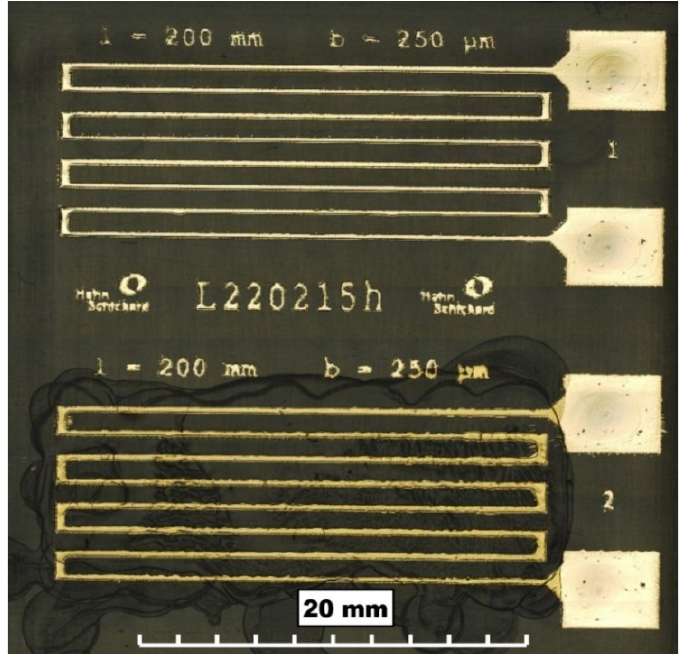
Figure 6. Inkjet-printed temperature sensor (1) without coating and (2) with coating.